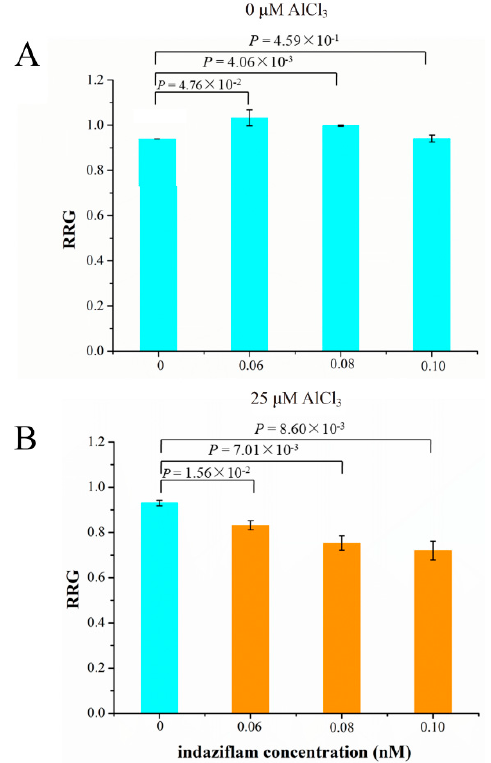
Figure 8. The effect of cellulose biosynthesis inhibitor (indaziflam) on the relative root growth (RRG) of soybean primary roots under 0 ( A ) or 25 μ M AlCl 3 ( B ). P values above the bars indicate the significant levels by Student’s t -tests.